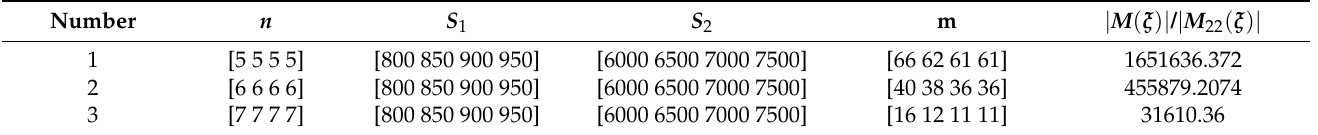
Table 13. Optimization results of test scheme.